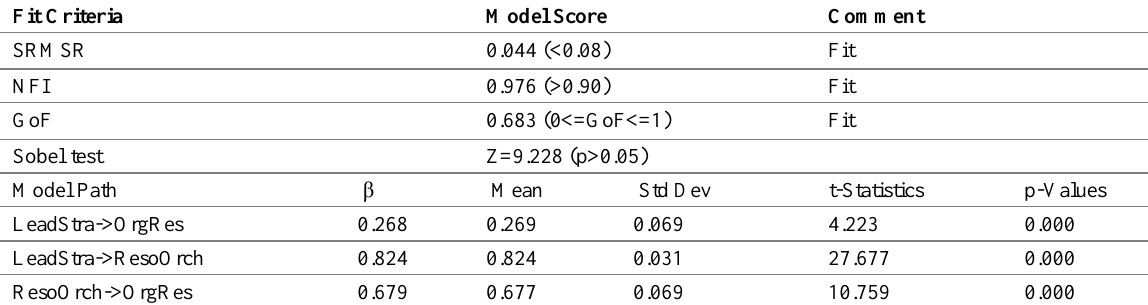
Table 7: Model Fit Criteria for Aggregate Resource Orchestration